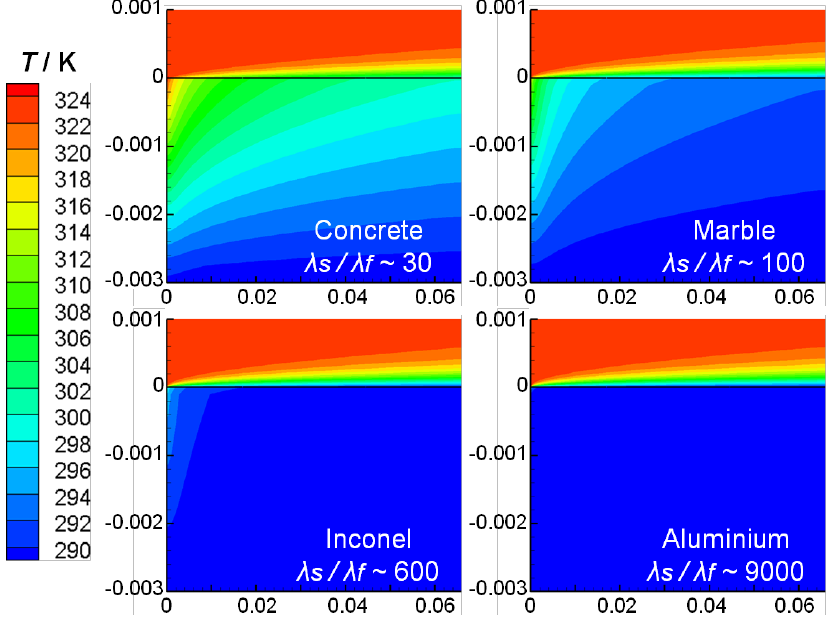
Figure 3. Temperature contours inside the boundary layer and solid with different thermal